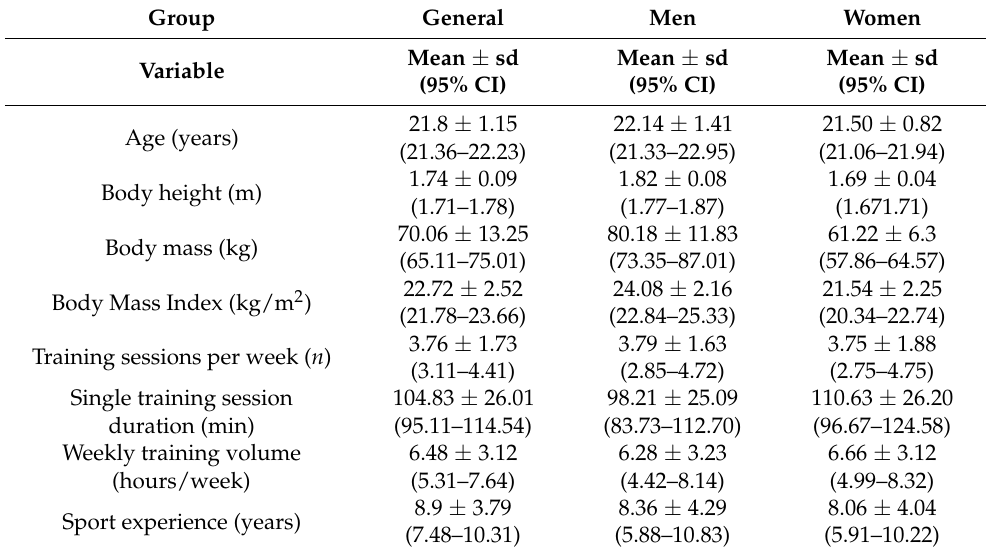
Table 1. Characteristics of the study